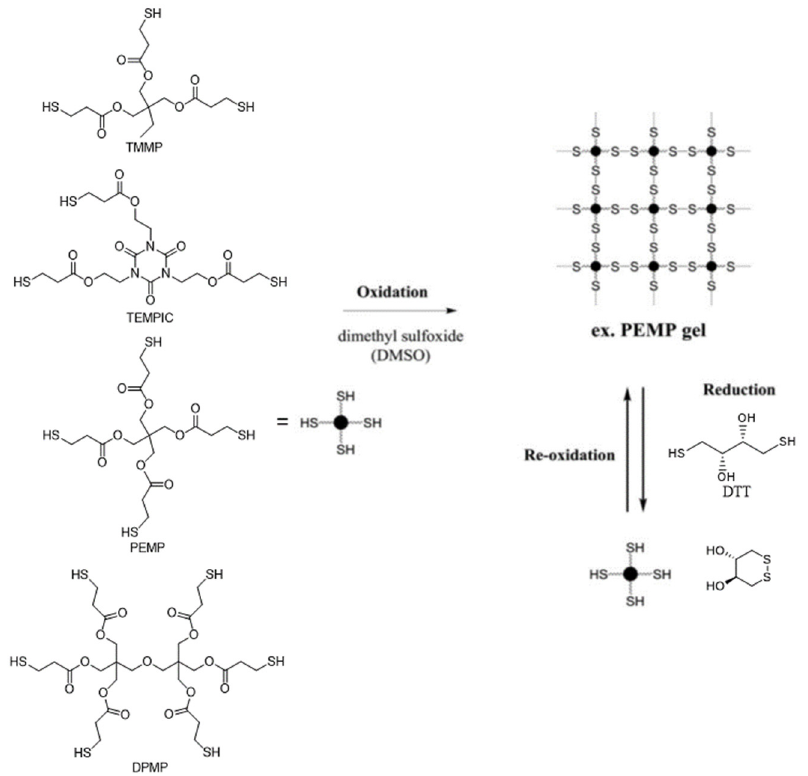
Figure 15. Redox behavior and synthesis of extended networks from multi-thiolated branched monomers—trimethylolpropane tris (3-mercaptopropionate) (TMMP), tris[(3-mercaptopropio- nyloxy-ethyl]-isocyanurate (TEMPIC), pentaerythritol tetrakis (3-mercaptopropionate) (PEMP), and dipentaerythritol hexakis (DPMP)--to generate disulfide linkages. Adapted with permission from [25]. Copyright (2017) Wiley Periodicals, Inc.